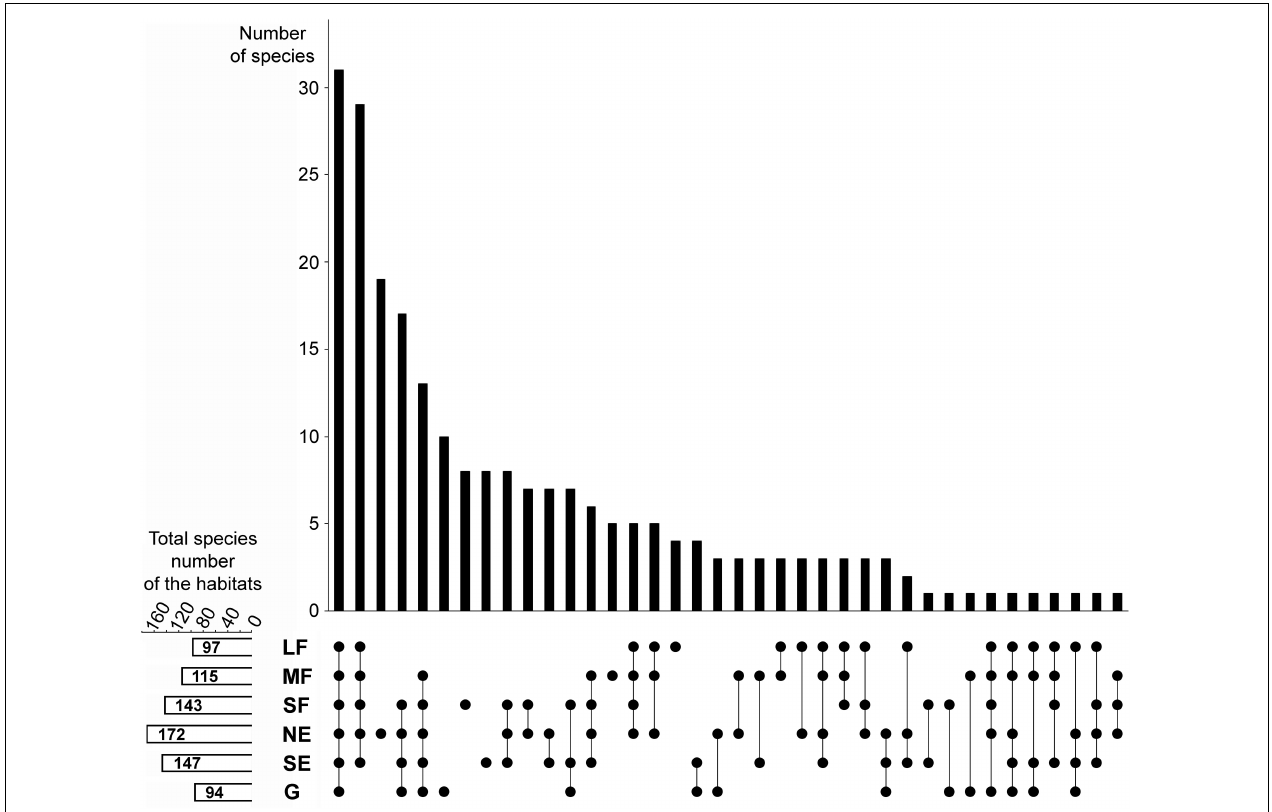
FIGURE 2 | Relationships among the studied habitats in terms of species composition overlaps and distinctness. The upper panel shows the number of those species that were found in the habitats indicated by the dots in the lower panel. For example, the first column shows that there are 31 species that were found in all six habitats, whereas the third column shows that there are 19 species which are restricted to the north-facing grassland habitat. The small panel in the bottom left corner shows the total (i.e., pooled) number of species in each habitat. LF, large forest patches; MF, medium forest patches; SF, small forest patches; NE, north-facing edges; SE, south-facing edges; G,